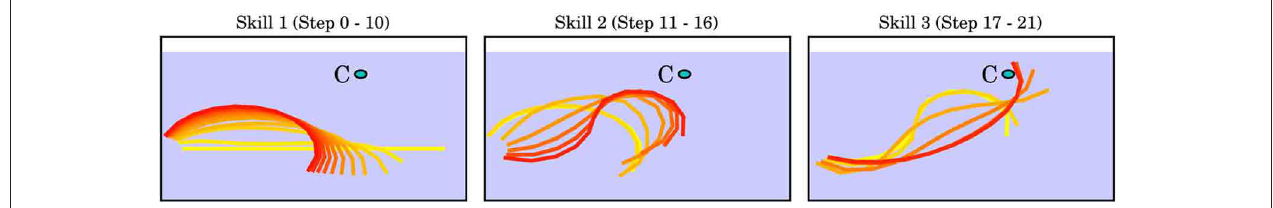
FIGURE 9 | Example trajectory of the octopus arm controlled by the IMRL agent. The trajectory corresponds to a sequence of three skills. Yellowly colored arms correspond to states at the beginning of skill execution while redly colored arms correspond to states at the end of skill execution.